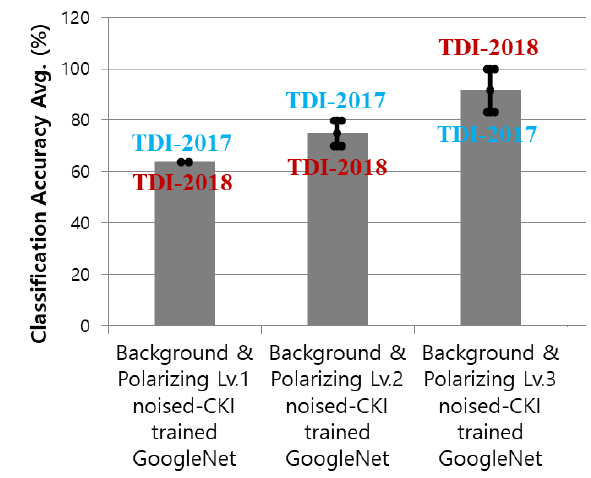
Figure 13. Classification results with TDI-2017 and TDI-2018 by GoogleNet trained with Background & Polarizing noised-CKI according to the polarizing